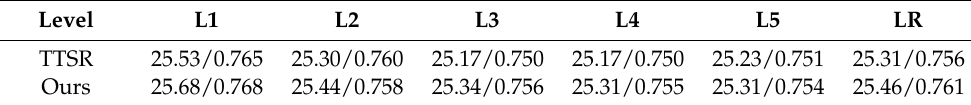
Table 2. Ablation study on reference images with different levels of similarity.